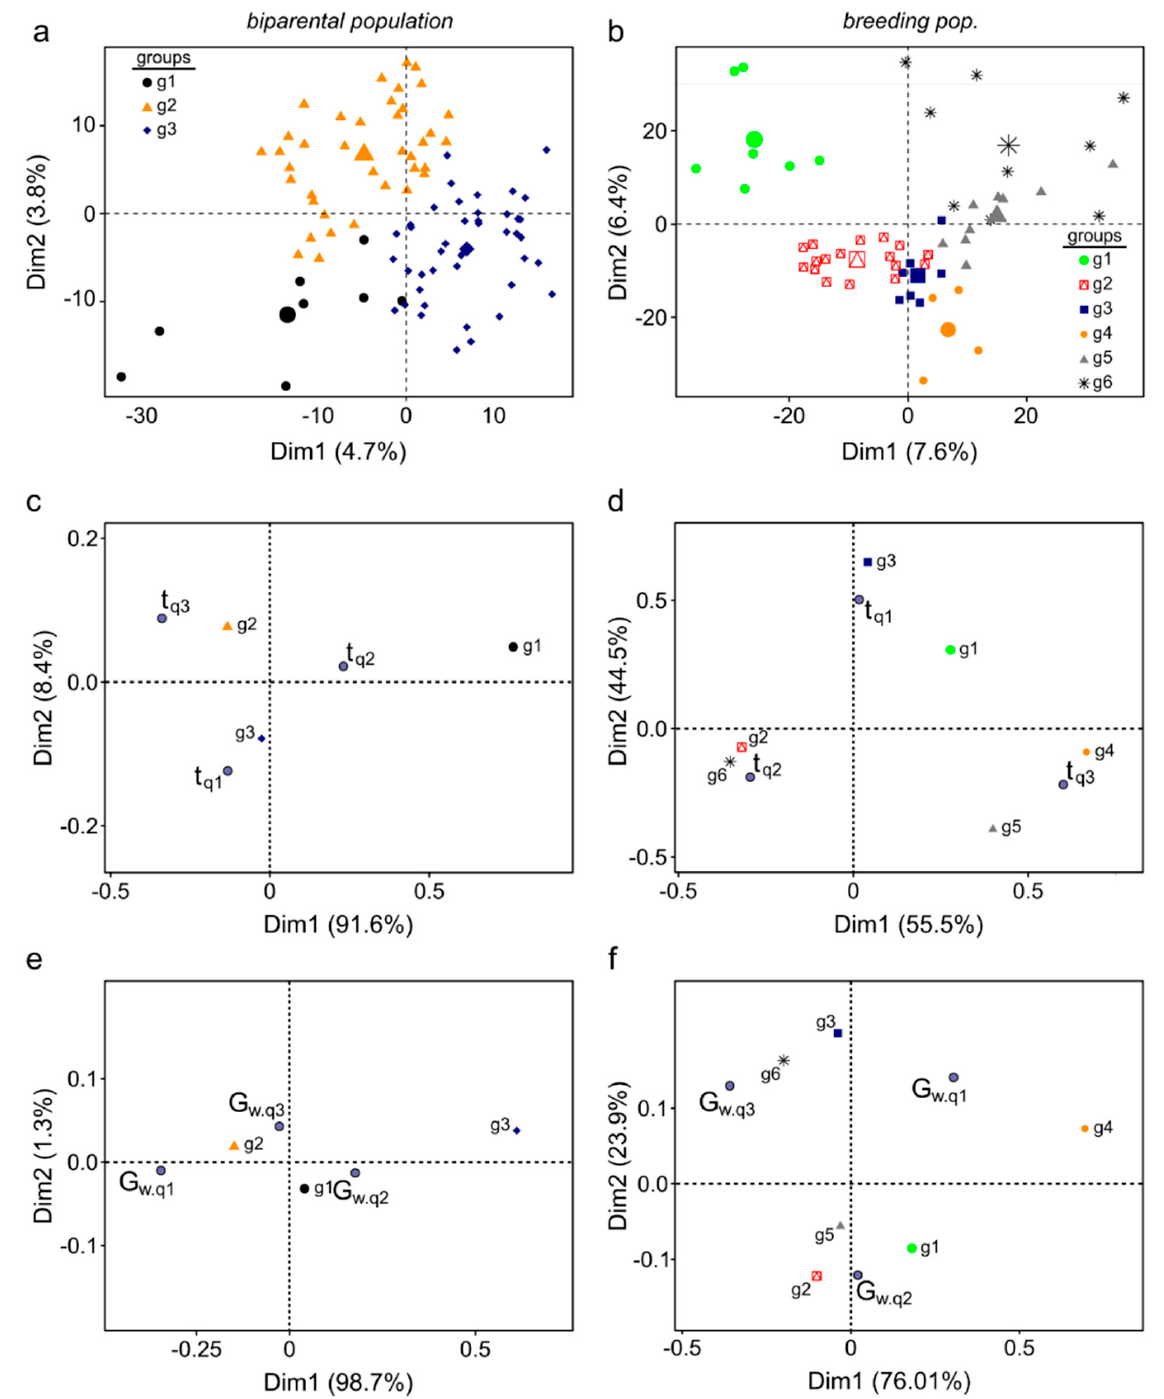
Figure 6. Population structure calculated from genotypic data (molecular markers), phenotypic data (parameters of the model), and the correspondence analysis. The groups were obtained by hierarchical clustering on the principal component (HCPCgenotypic). ( a ) Biparental population: g1, g2, and g3 groups. ( b ) Breeding population: g1, g2, g3, g4, g5, and g6 groups. Correspondence analysis of the contingency table between groups based on the parameters of the models and groups according to genotype. ( c , e ) Biparental population. ( d , f ) Breeding population. Population structure calculated from parameters t 0.5 and G w of the model. tqn and G wqn were obtained by hierarchical clustering on the principal component (HCPCphenotypic).